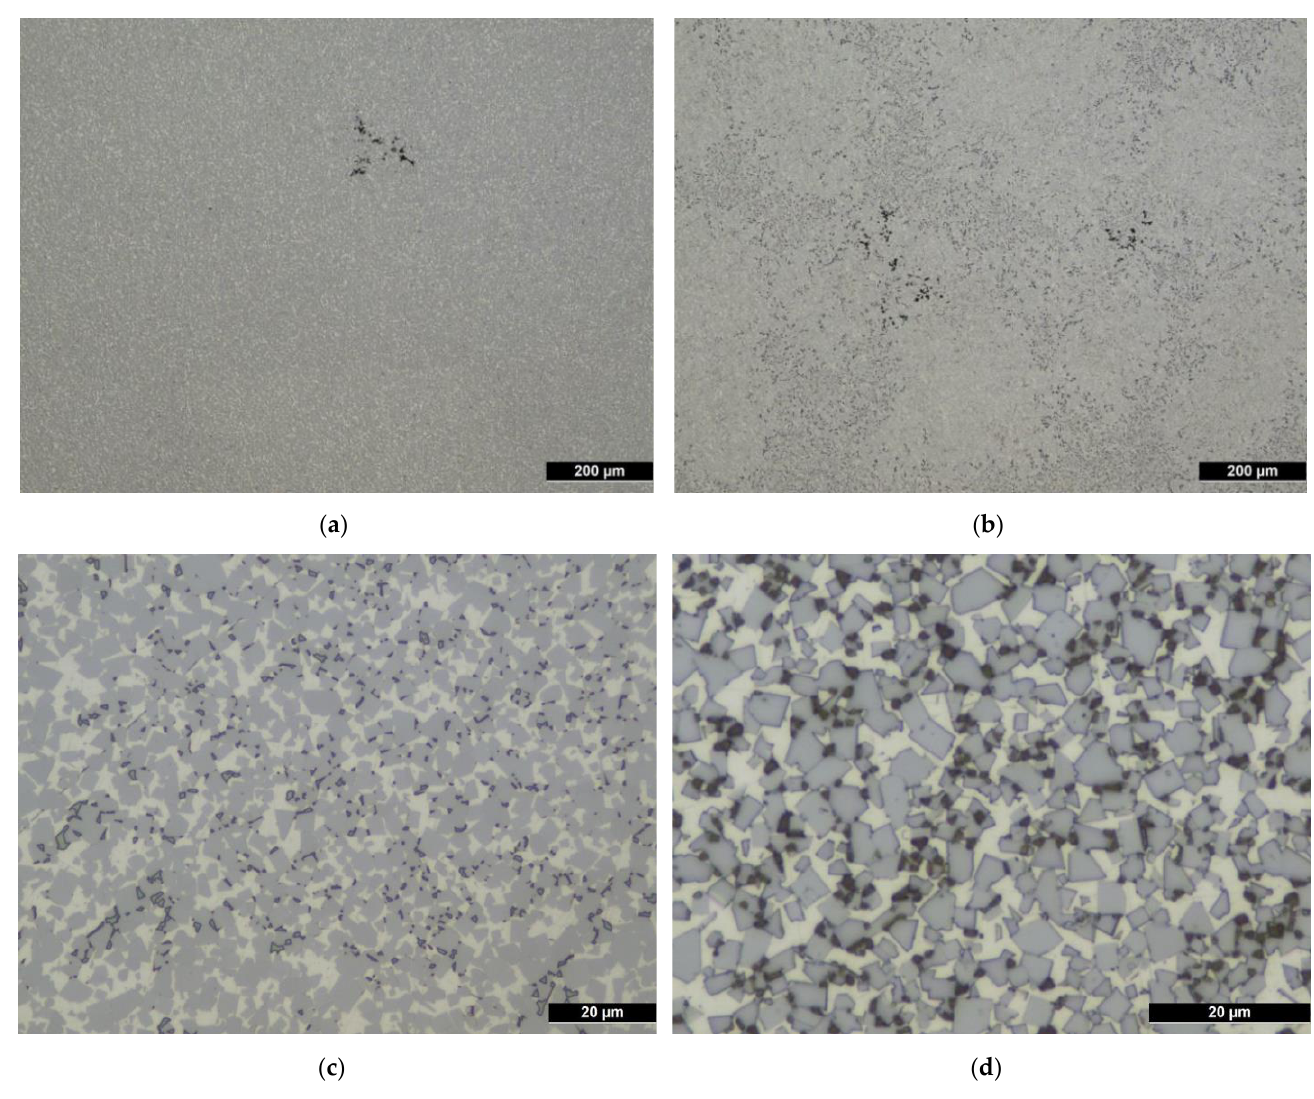
Figure 7. Co-base grades: precipitation of free-C ( a , b ) and submicron sized Cr-carbides in grades with [Cr] > 8 m% ( b – d ). For details on the samples, see Table 2.